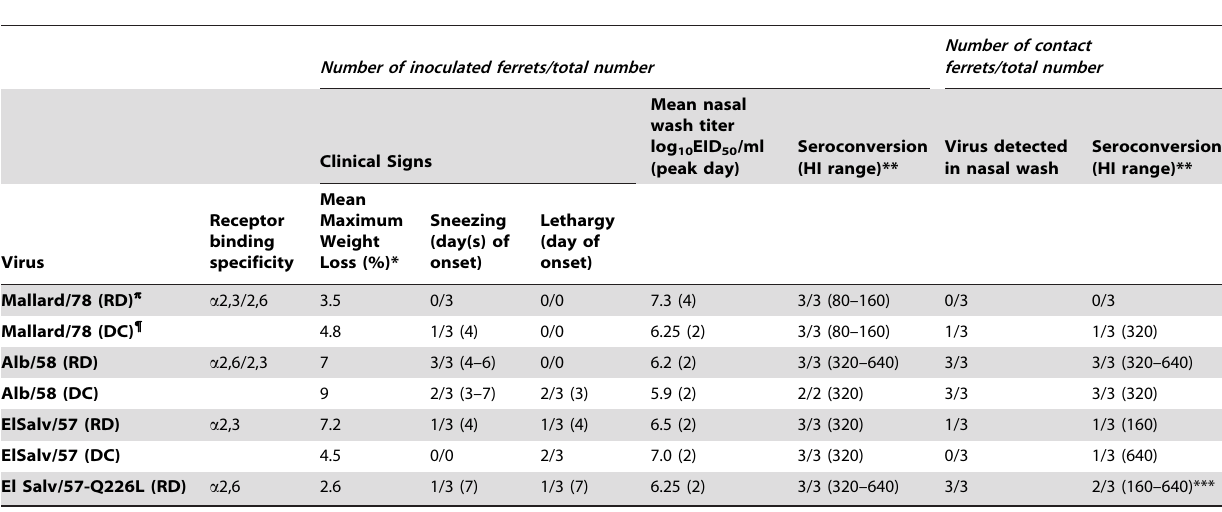
Table 1. Clinical signs, virus replication, seroconversion, and transmission in ferrets inoculated with H2N2 viruses.